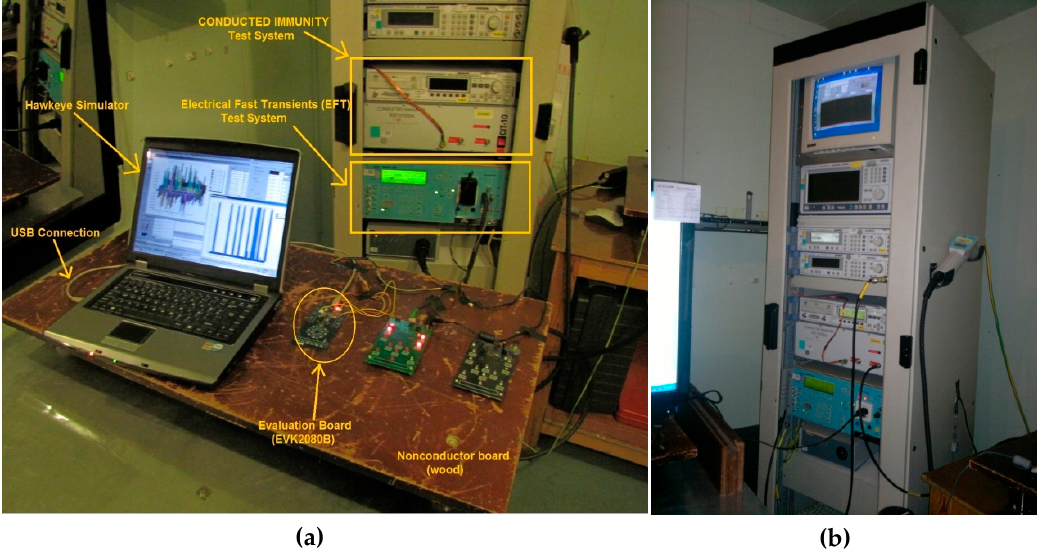
Figure 12. Measurement set-up with EFT and conducted immunity test devices.